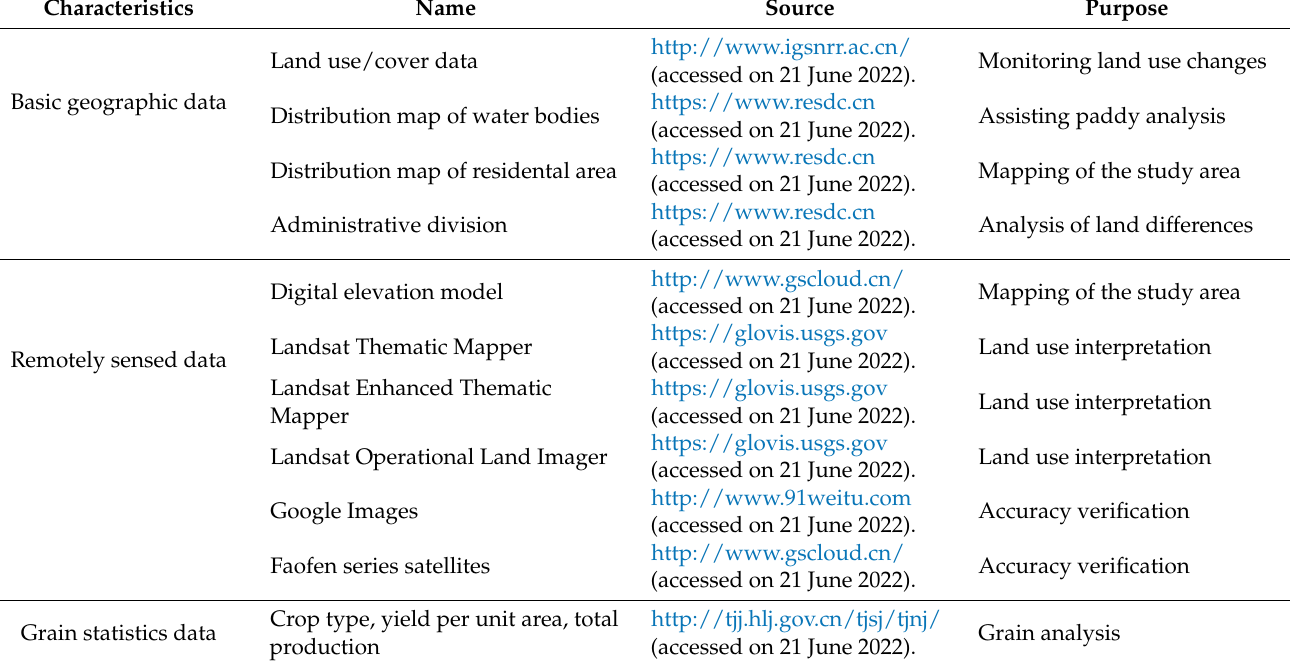
Table 1. Descriptions of the main data used in this study, including the indicators of characteristics, name and